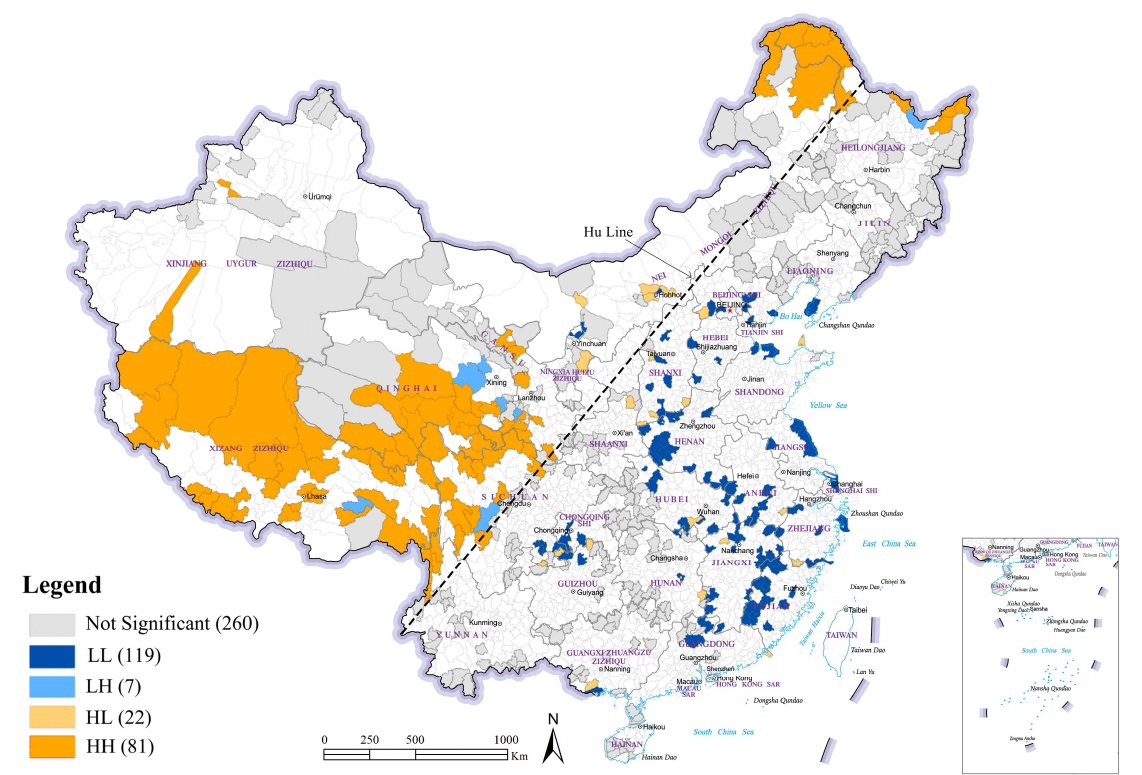
Figure 5. Aggregation map of the local spatial association of multidimensional relatively poor